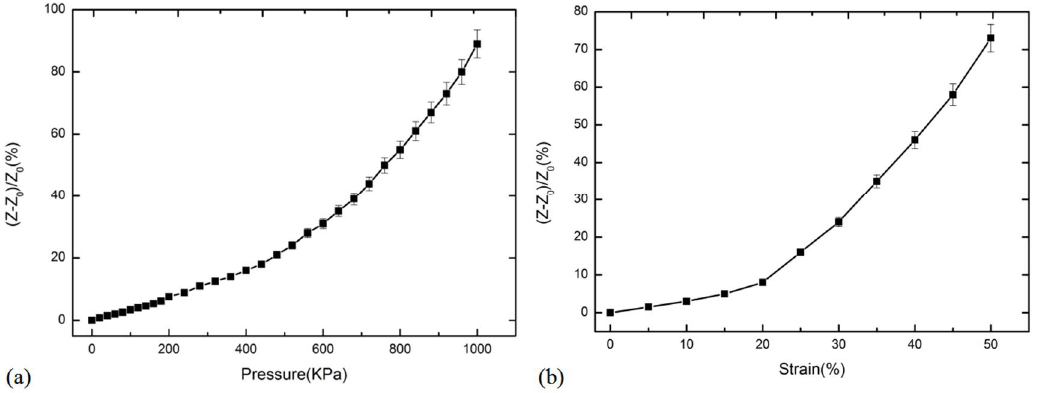
Figure 6. The relative impedance change of CNT/PDMS composite under ( a ) pressure and ( b ) tensile strain.